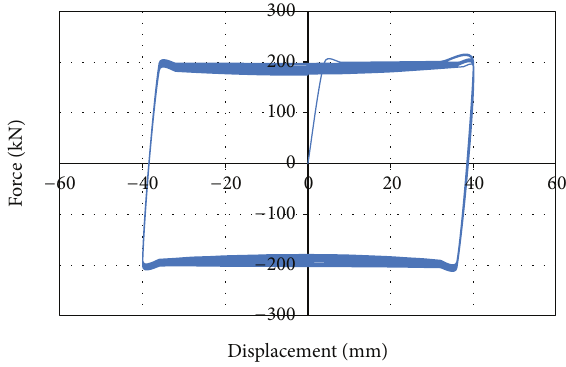
Figure 14: Hysteretic force-displacement curve of the improved CFD (10 cycles and frequency = 0.7 Hz).